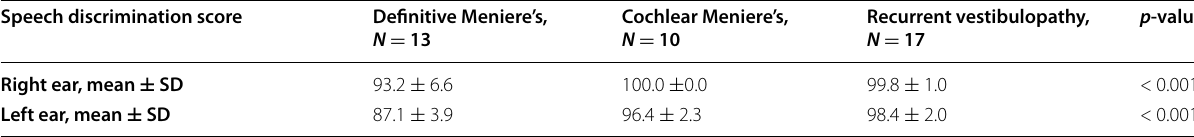
Table 7 Speech discrimination